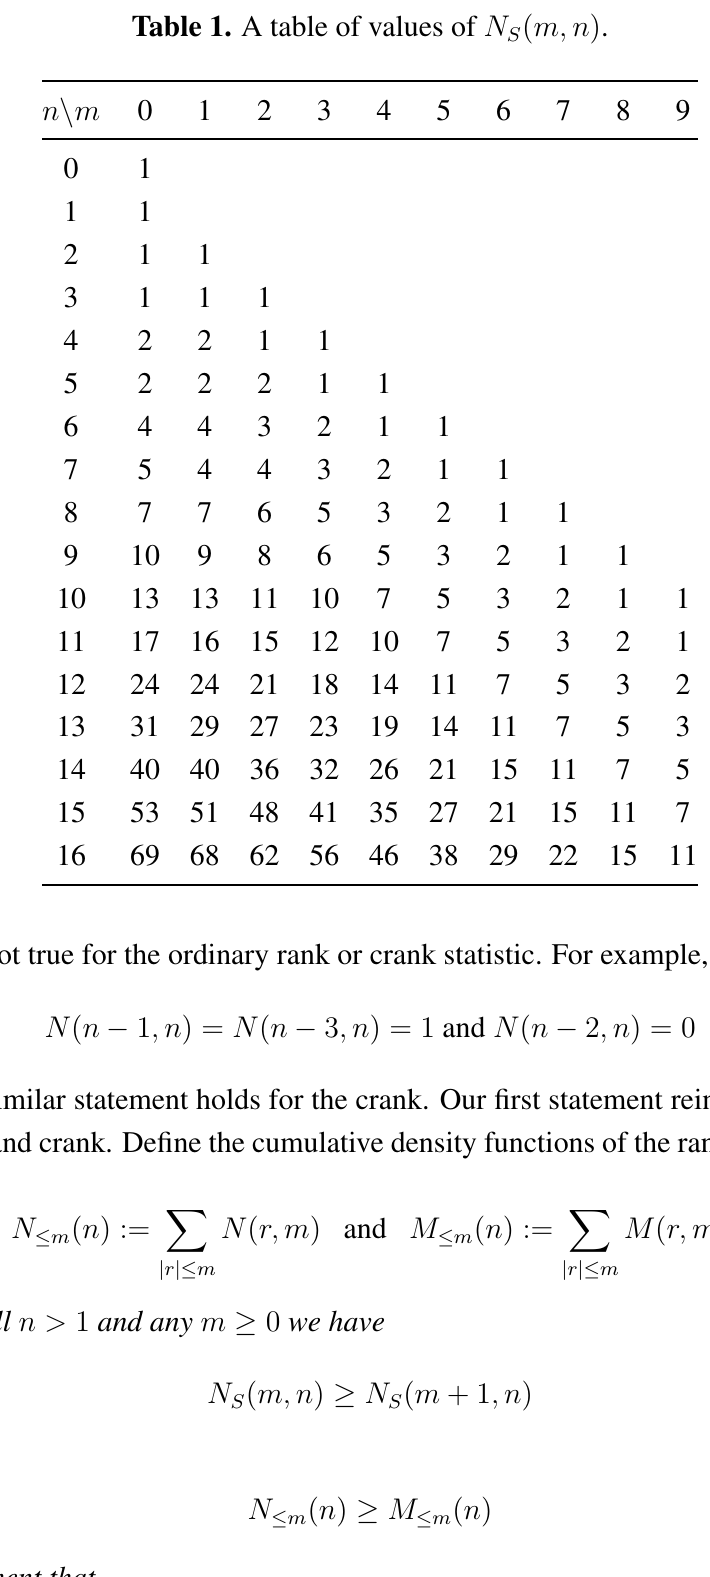
Table 1. A table of values of N